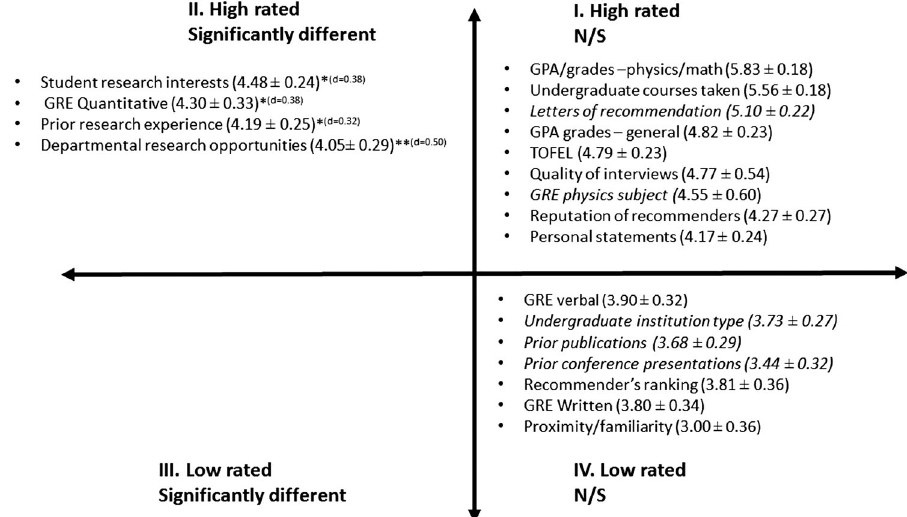
FIG. 7. Categorization of master ’ s admission criteria for the subset of master ’ s ( n ¼ 33 ) program (* p < 0 . 05 ; ** p < 0 . 01